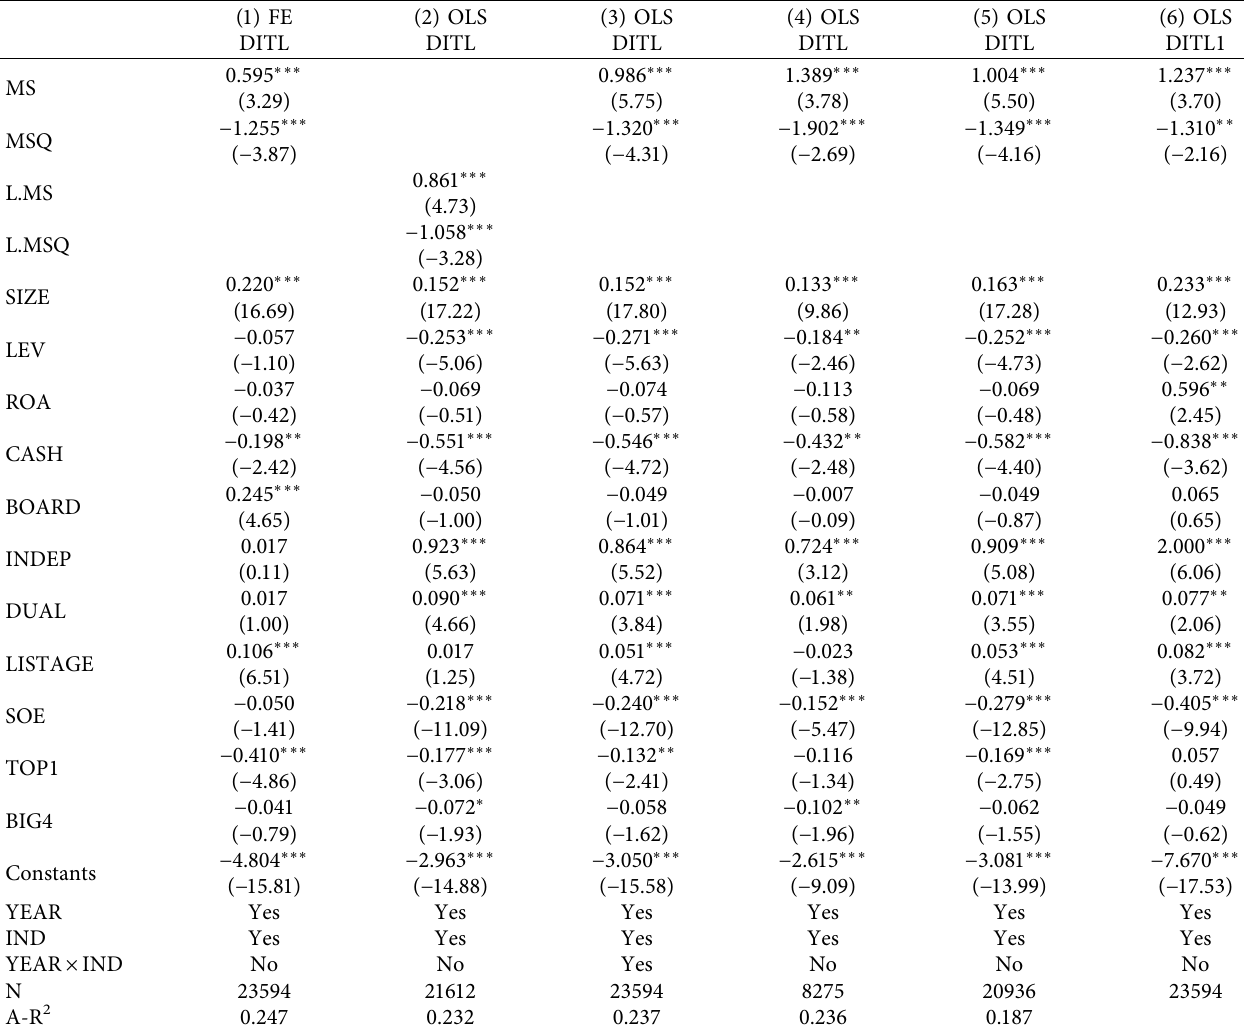
Table 3: Endogeneity treatment and robustness